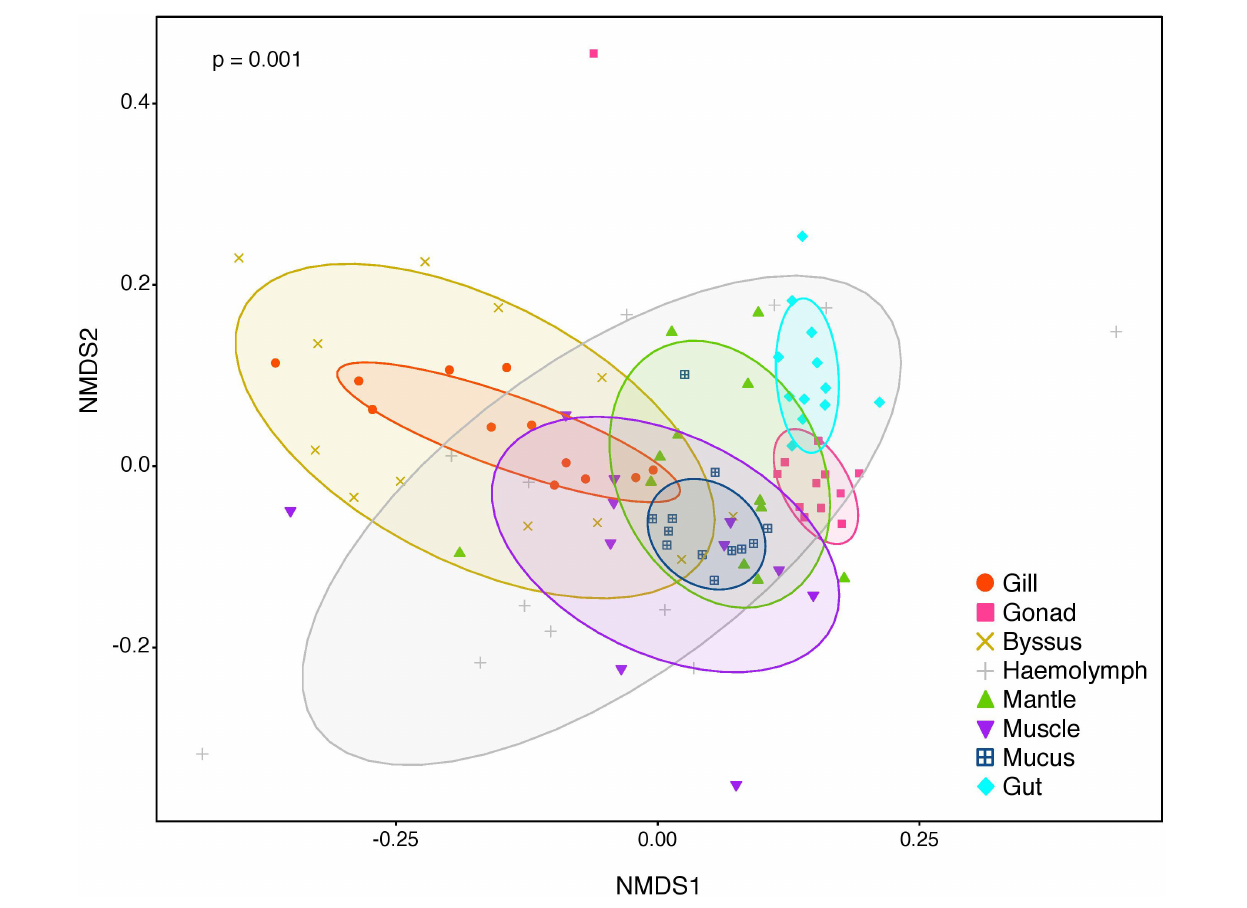
FIGURE 2 | Non-metric multidimensional scaling (nMDS) of bacterial community composition of P. margaritifera at the OTU-level. Each symbol colour denotes one tissue (Gill = red, Gonad = pink, Byssus gland = gold, Haemolymph = grey, Mantle = green, Muscle = purple, Mucus = blue, Gut = cyan), ellipses are drawn around each group’s centroid (95%). P -values indicate significant differences in bacterial community composition between tissues (PERMANOVA and ANOSIM